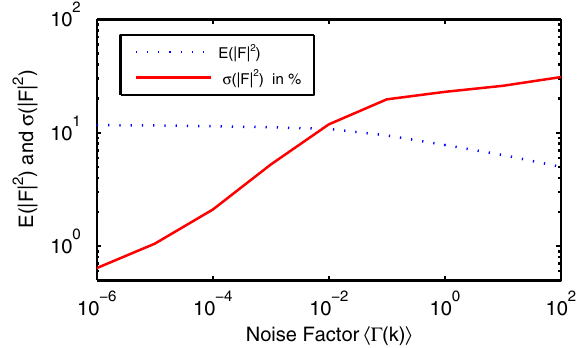
FIG. 9. Spectrum of the dimensionless power j F ð ! Þj 2 vs the frequency normalized to the resonant frequency ! are averaged over 1600 statistically independent simulations.